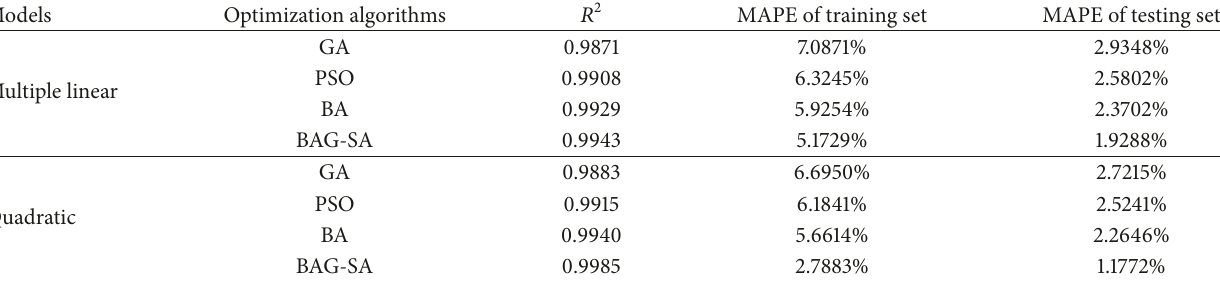
Table 4: Comparison of results from various electricity demand estimation models.